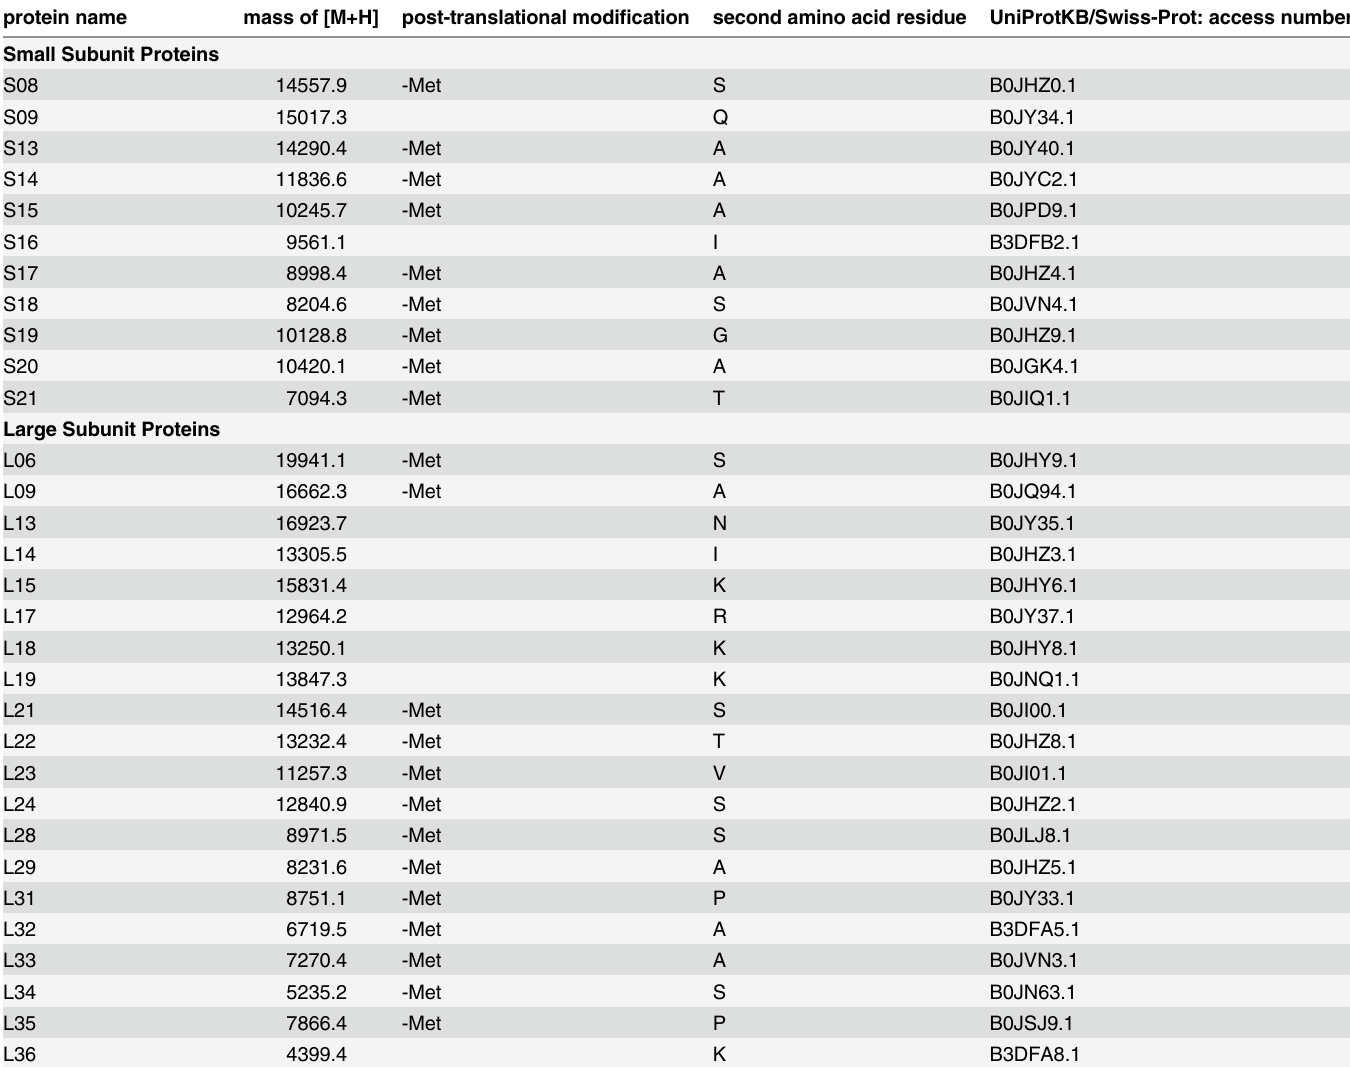
Table 1. Assigned ribosomal subunit proteins of M . aeruginosa NIES 843. protein